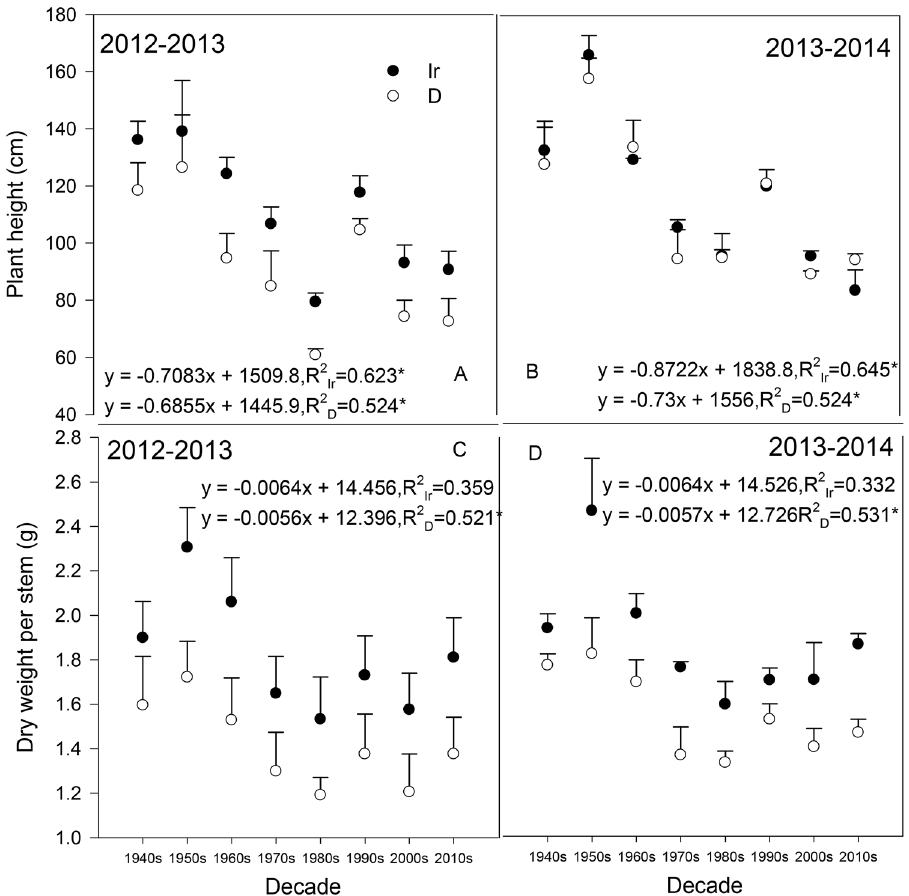
Figure 2. Plant height and stem dry weight at anthesis in 2012–2013 and 2013–2014. The data represent the mean ± SE and sample number (N) = 30; * significant at P < 0.05; Ir indicates the irrigation treatment; D indicates the drought